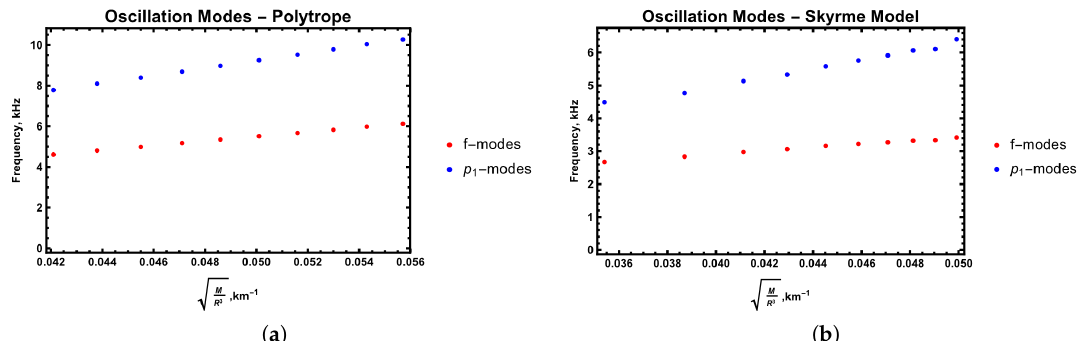
Figure 3. The trend of f- and p-modes with the square root of the mean density of the neutron star, given a polytropic equation of state ( a ) and a Skyrme (Model A) equation of state ( b